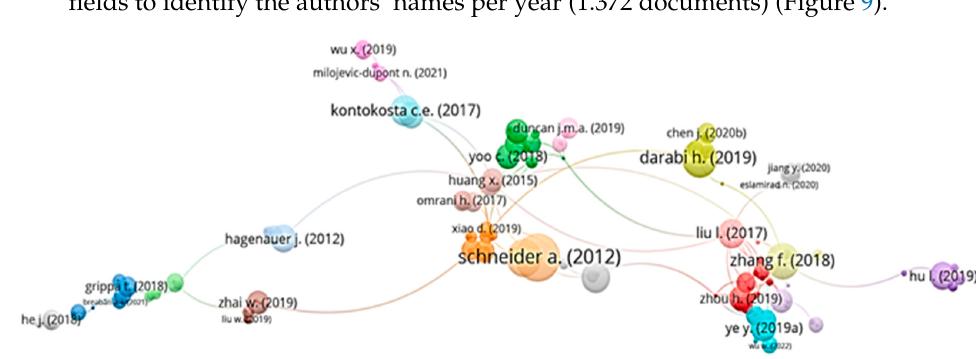
Figure 9. Bibliometric analysis of ML and urban applications (authors per year), Scopus database. An overview of the correlations of the existing works and studies of ML and urban fields to identify the number of citations per country (1.372 documents) (Figure 10).